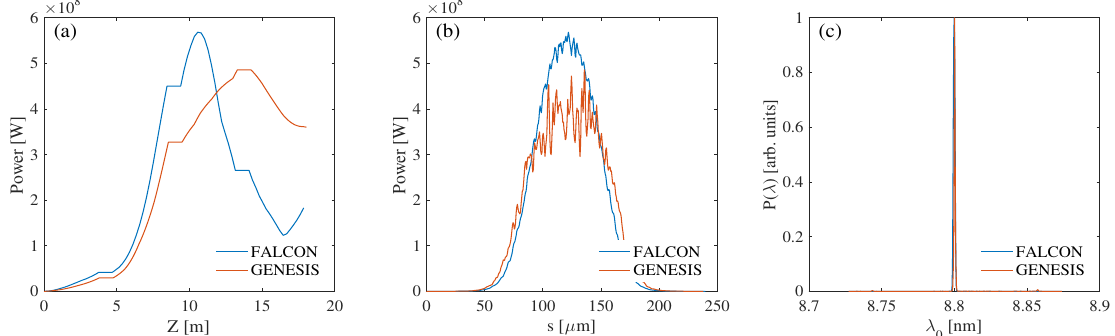
Figure 3. The simulation results of ( a ) the FEL power evolution along the radiator; ( b ) the power profile; and, ( c ) the spectrum at saturation. The blue and red lines represent the FALCON and GENESIS simulations, respectively.